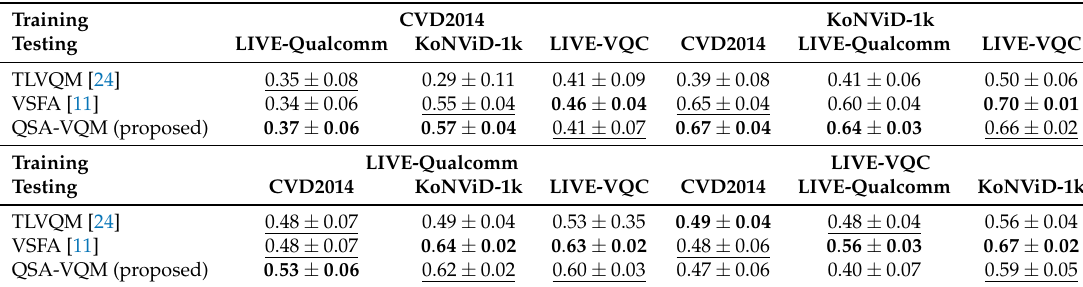
Table 3. SROCC in the Cross-dataset setup. In each column, the best and second-best values are marked in boldface and underlined,